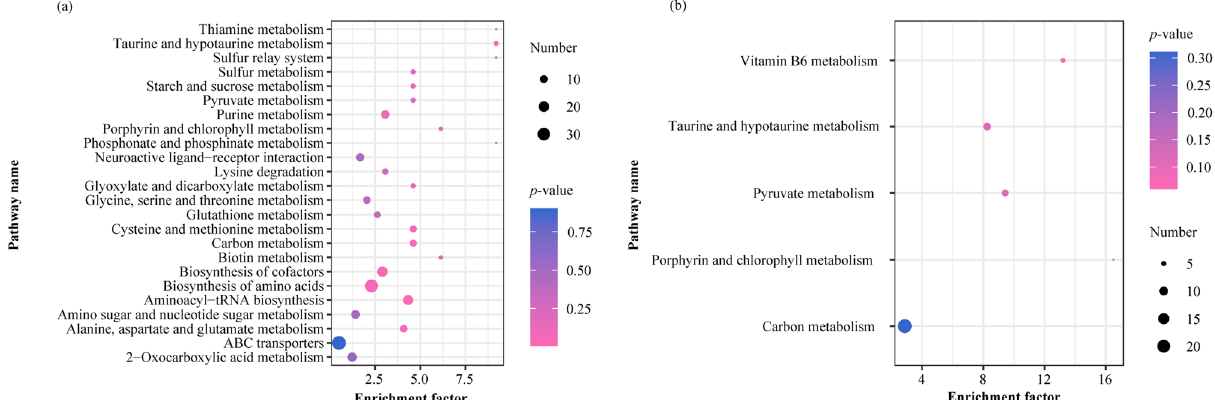
Figure 7. Statistical scatter plot of pathway enrichment of differential metabolites. ( a ) Positive ion (POS) and ( b ) negative ion (NEG) modes; the x -axis and y -axis represent enriched metabolic pathways and enrichment factors, respectively; rich factor refers to the ratio of differentially expressed metabolites to all metabolites annotated to this metabolic pathway; the larger the rich factor, the greater is the degree of enrichment. P -value, ranging from 0 to 0.05; the closer to 0, the more significant is the enrichment.